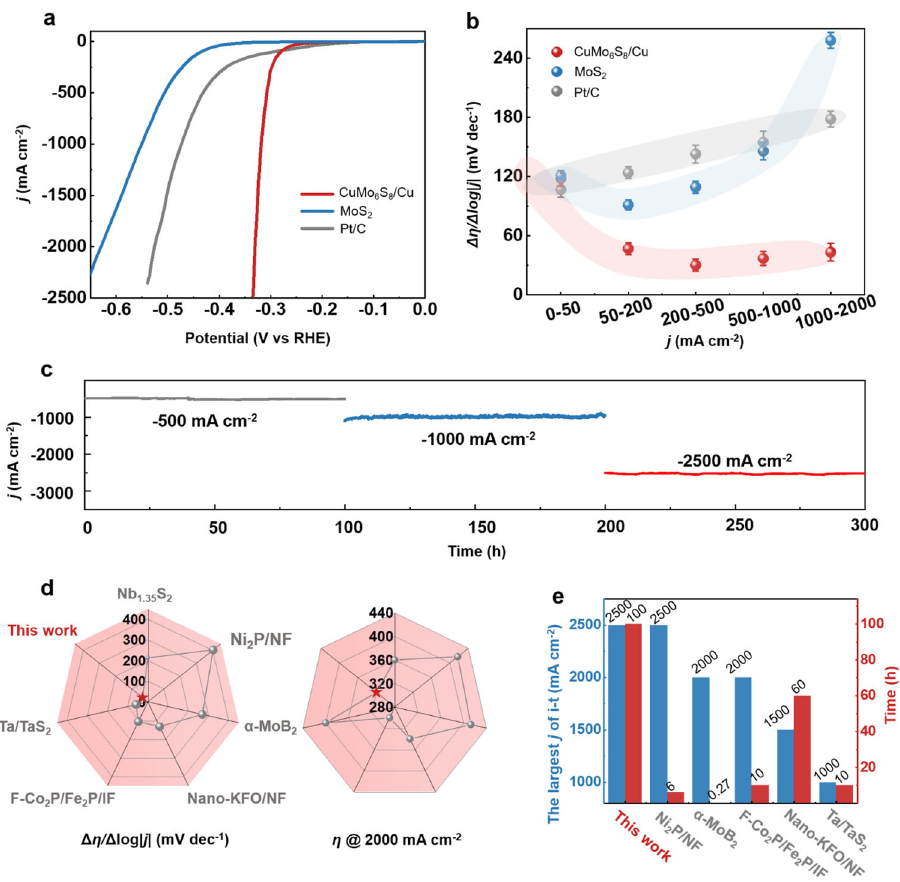
− 0.94V vs RHE without iR correction, respectively. d , e Comparisons of HER per- formance and stability of the Cu/CuMo 6 S 8 electrode with non-noble metal elec- trocatalysts operated at a current density above 2000mAcm − 2 . From left to right: the Δ η / Δ log| j |ratio@1000mAcm − 2 − 2000mAcm − 2 and η @ 2000mAcm − 2 ( d )and the largest tested j of i-t test and its corresponding time ( e